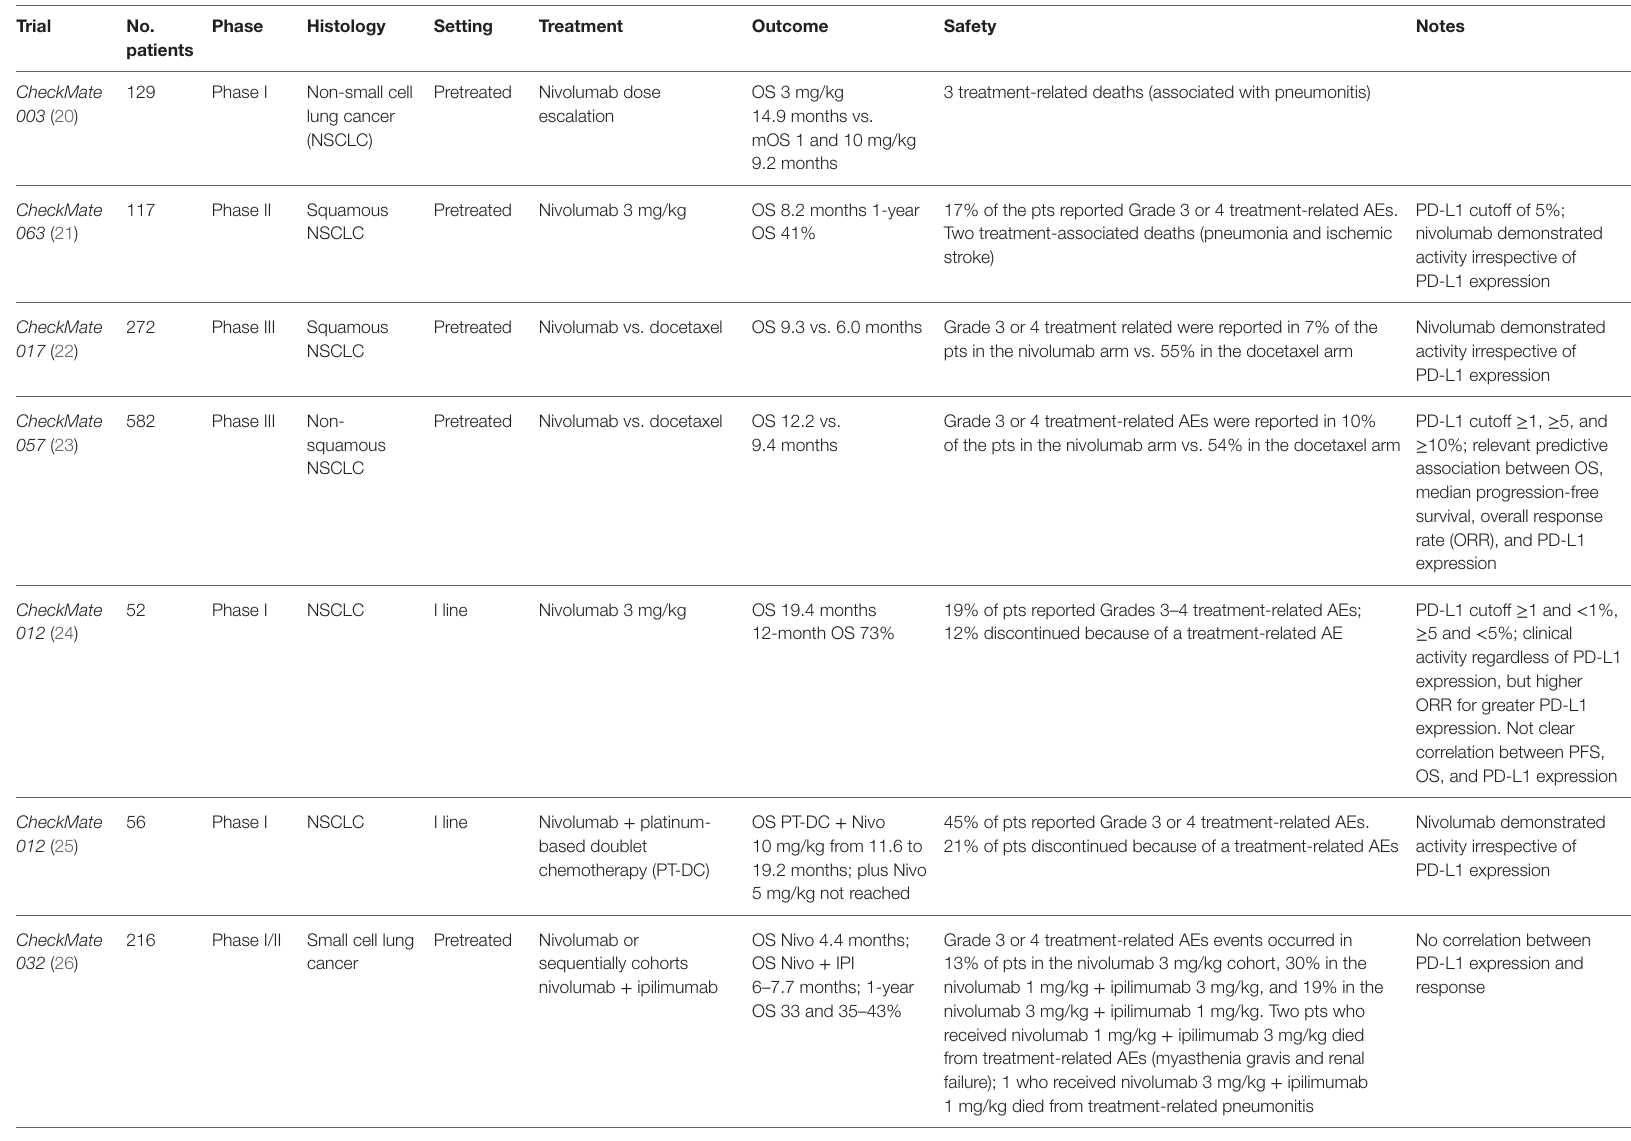
TABLe 1 | Major clinical trials of nivolumab in lung